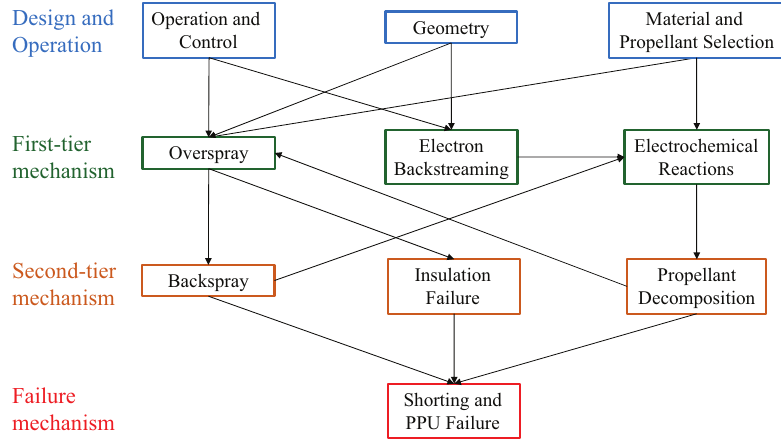
Figure 2. Hierarchical failure tree for electrospray